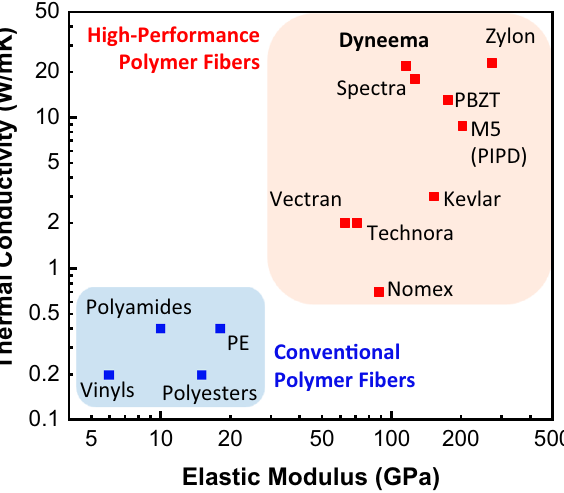
Figure 1. Elastic modulus and thermal conductivity of conventional polymer fibers (in blue) and commercially produced high-performance polymer fibers (in red). The high-performance polymer fibers typically have ~ 1–2 orders of magnitude higher thermal conductivity and elastic modulus (note the log scales). Data compiled from references 28,30–39 with details for the high-performance fibers summarized in Table 1.